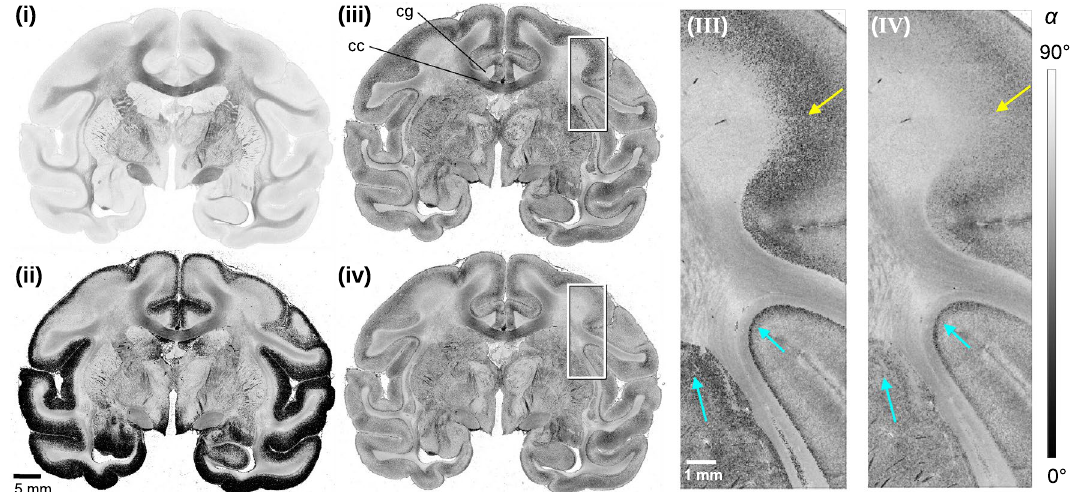
Figure 5. Inclination maps of the coronal vervet brain section computed with different models (Eqs. 3, 7 and 8): ( i ) unweighted model ( α LM ) applied to whole section, ( ii ) transmittance-weighted model ( α HM ) applied to whole section, ( iii ) both models applied separately to LM- and HM-regions, ( iv ) linear transition between both models depending on the computed HM-probability value. The images on the right ( III , IV ) show enlarged views of the regions marked by the white rectangles in ( iii ) and ( iv ), respectively. cc = corpus callosum, cg = cingulum. The yellow and cyan arrowheads point to two different types of transition zones located between LM- and